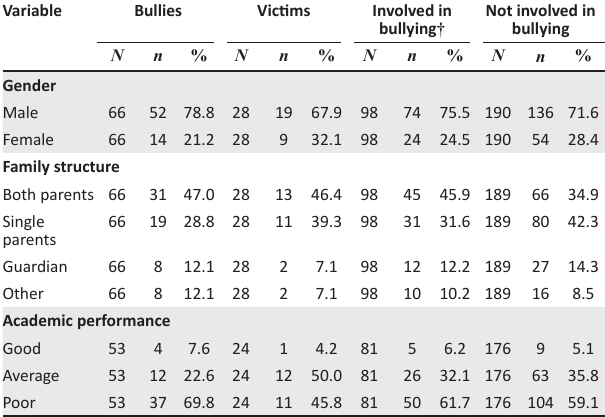
TABLE 1: Demographic details of children treated at the Free Sate Psychiatry